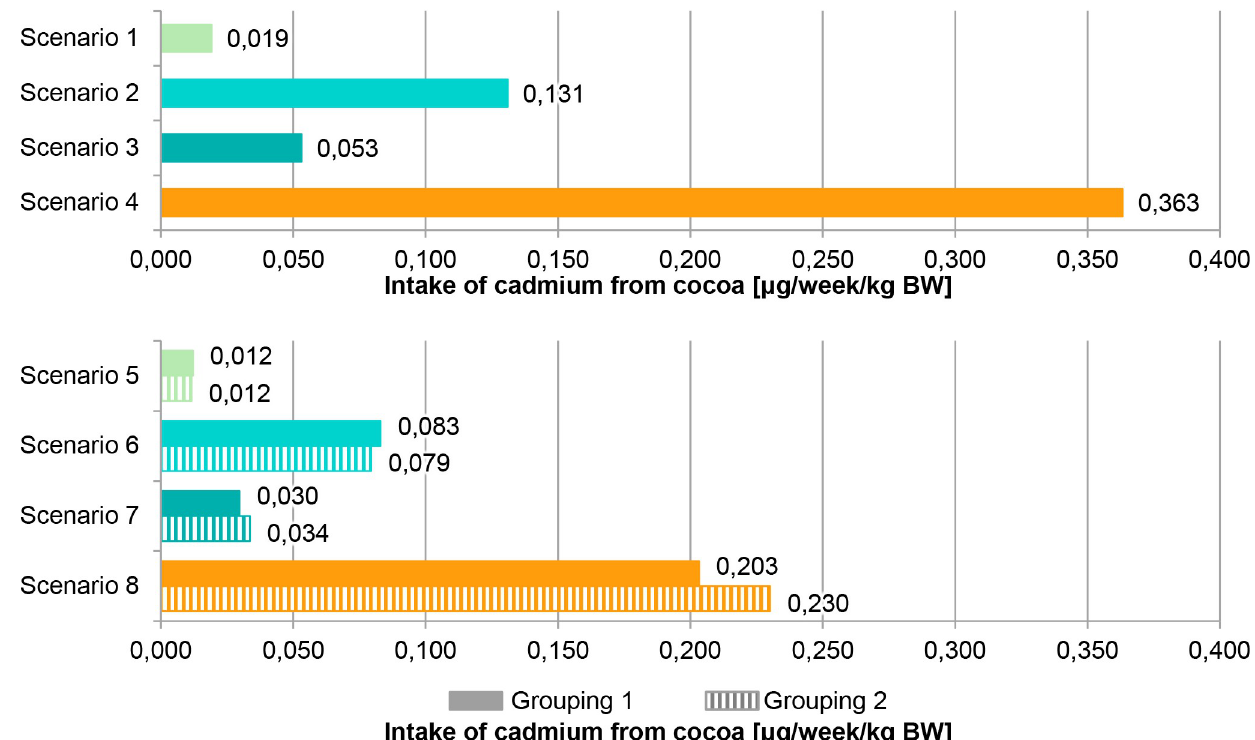
Fig 2. Chronic intake of cadmium from cocoa powder. Calculations based on German Food Monitoring (GFM) 2005–2015 and German National Nutrition Survey II (NVS II) dietary history interview. Same colour shows corresponding scenarios (standard (1–4) and origin-related (5–8)). While standard scenarios use percentile 95 (P95) for high concentrations, origin-related scenarios use mean concentrations of different origins. BW (body weight).